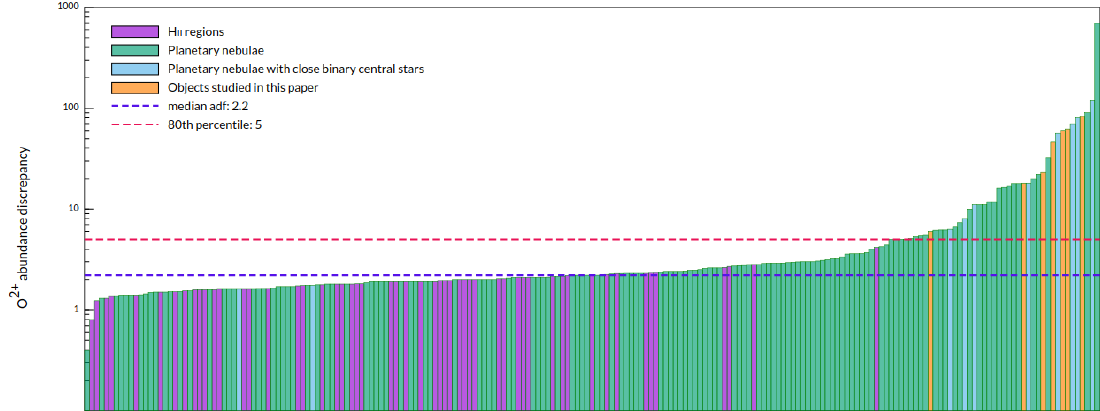
Figure 2. Two hundred and seven measurements of adf (O 2 + ) available in the literature as of September 2018, including the new measurements presented in this paper, shown in rank order. Objects with close binary central stars are highlighted in blue, H II regions in purple and the objects studied in the current work in orange. A full list of the individual objects and references used to compile this figure is available at